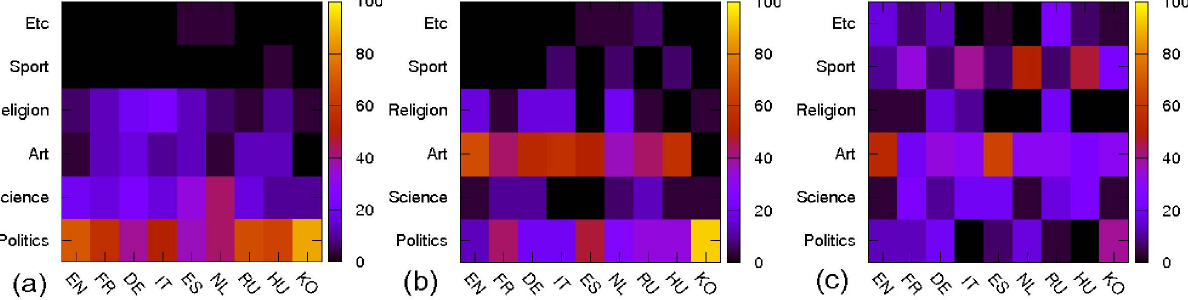
Figure 3. Distribution of top 30 persons in each rank over activity fields for each Wikipedia edition. Panels correspond to (a) PageRank, (b) 2DRank, (3) CheiRank. The color bar shows the values in percents.